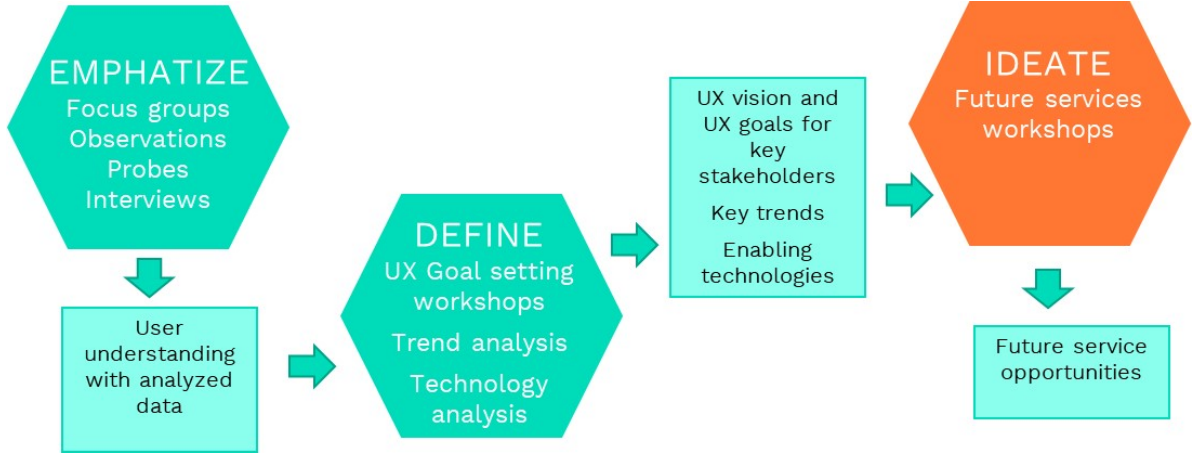
Figure 1. The design thinking process phases and their results. Table 1. DT process methods, participants and aims.